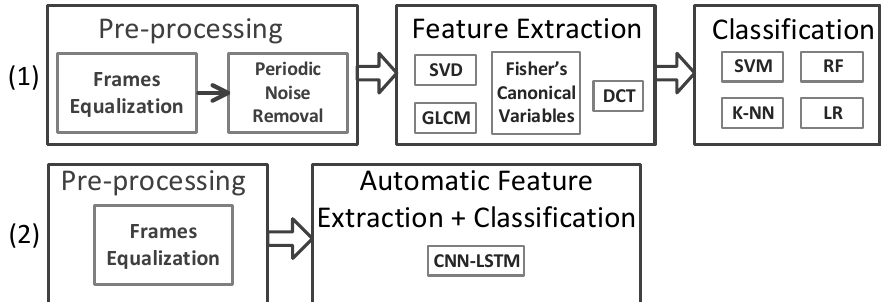
Figure 4. The data processing flow for the two analysis